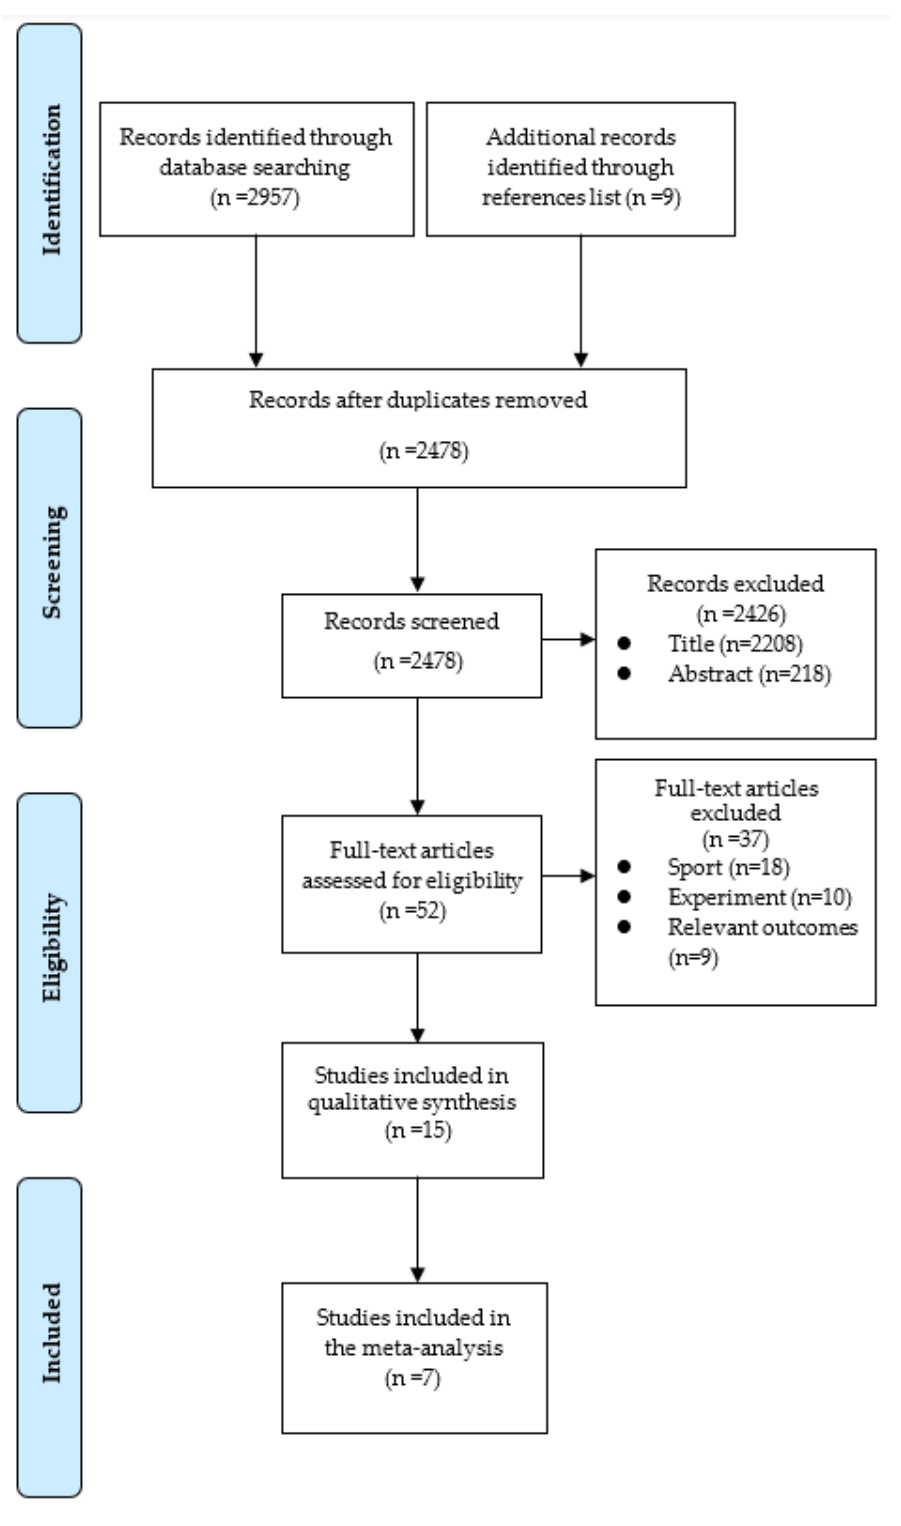
Figure 2. Flowchart of literature screening process.